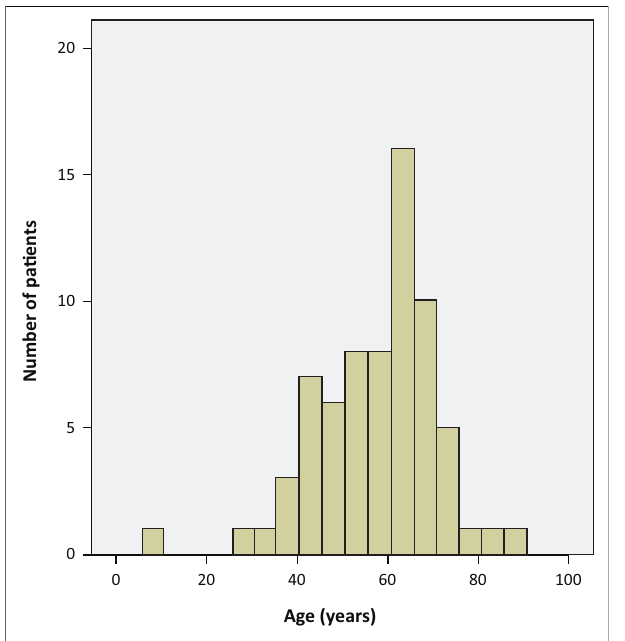
FIGURE 2: The immunohistochemical expression of gastrointestinal stromal